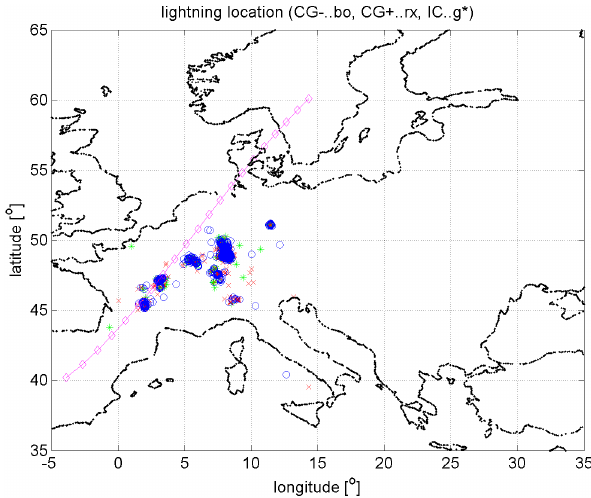
Fig. 2. Lightning discharges and the magnetic footprints of the MAGION-5 satellite from 00:15 UT to 00:35 UT on 5 June 2000. Circles (blue) correspond to − CG discharges, crosses (red) to +CG discharges and asterisks (green) to IC